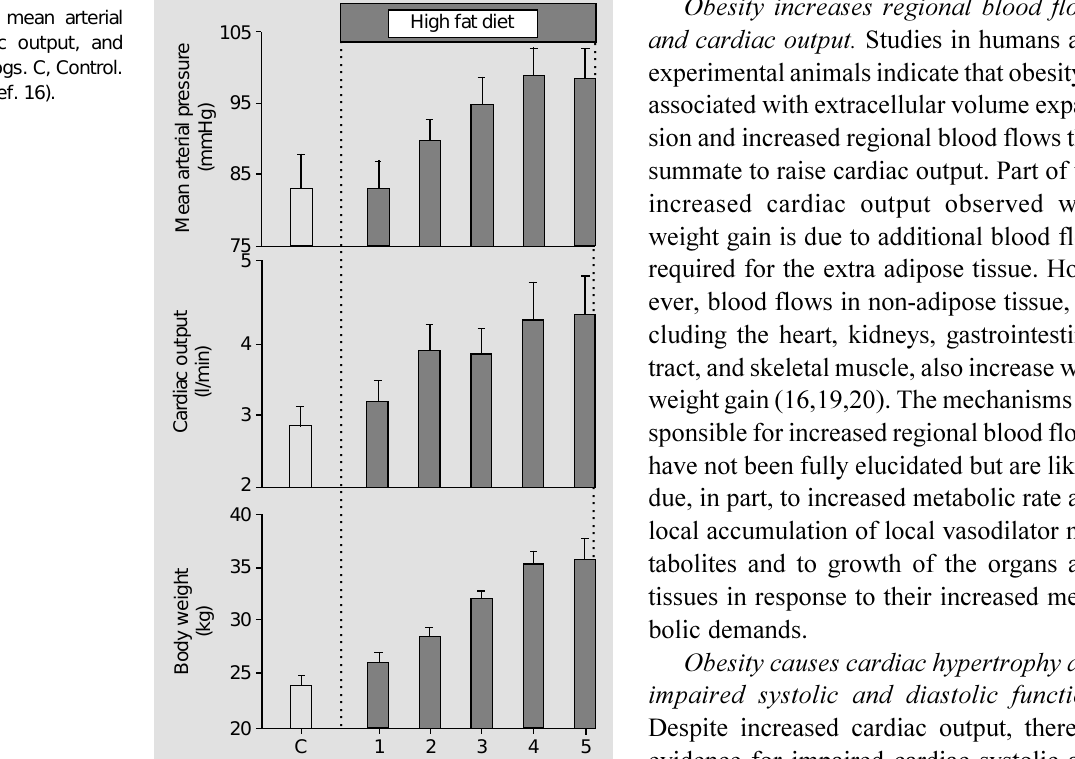
Figure 2 - Effects of 5 weeks of a high fat diet on mean arterial pressure, cardiac output, and body weight in dogs. C, Control. (Redrawn from Ref.